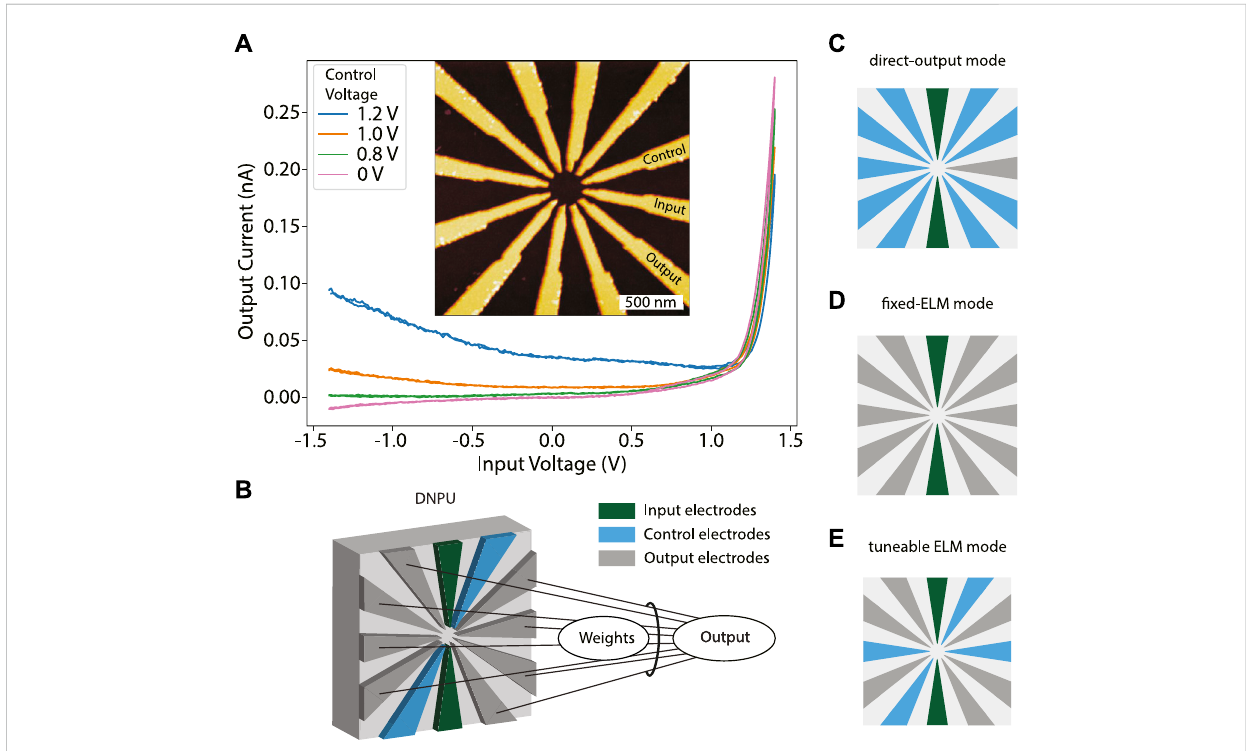
FIGURE 1 Dopant Network Processing Units as tuneable extreme learning machines: (A) IV curves measured between an input and an output electrode of a 12-electrode dopant network processing unit (DNPU), for different control voltages applied to a third control electrode (0 V is applied to the other electrodes),exhibitingnegativedifferentialresistance(NDR)whenthecontrolvoltageincreases(orangeandbluecurves).Inset:atomicforcemicroscope (AFM)imageoftheDNPU. (B) SchematicofaDNPUusedinthe “ tuneableELMmode ” ,withinput(green),output(grey)andcontrol(blue)electrodes. The fi nal output of the system is obtained by linearly combining the output currents with tuneable weights. (C) Schematic of the conventional, ‘ direct- output mode ’ . In this case there is a single output (without linear weight factor), while the other electrodes are either used as input or control. (D) Schematicofthe ‘ fi xed-ELMmode ’ :allelectrodesareeitherinputsoroutputs,wherethelatterarelinearlycombinedtoformtheoutput. (E) Schematicof the “ tuneable ELM mode ” , which is a hybrid of the modes shown in (C) and (D)